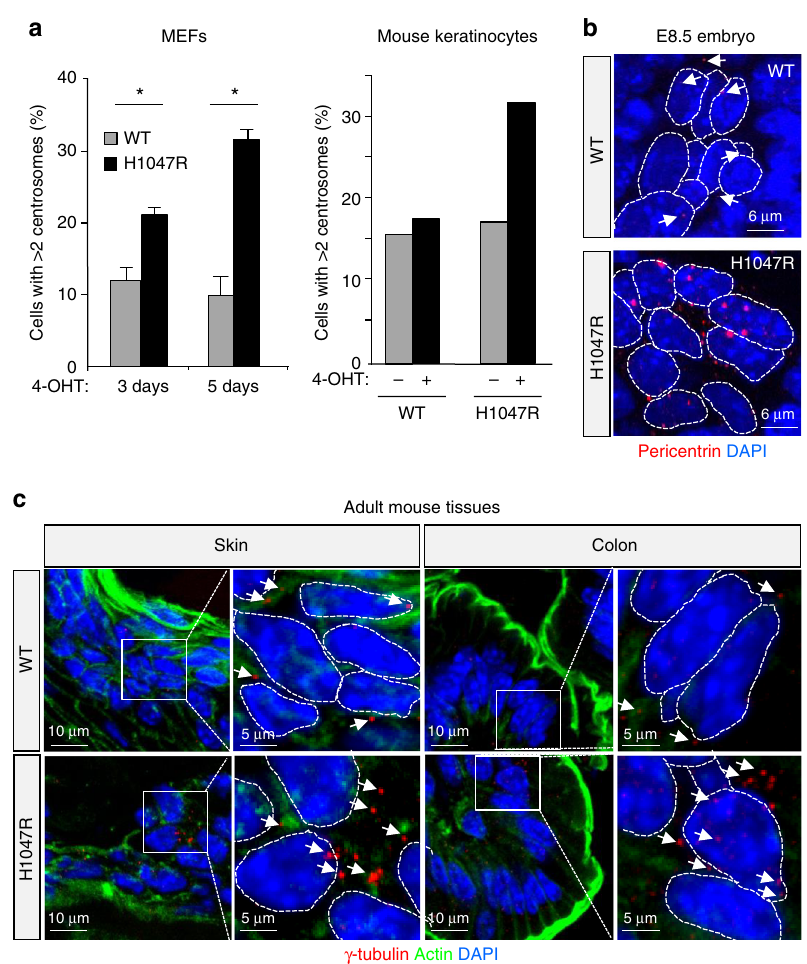
Fig. 2 p110 α H1047R expression leads to centrosome ampli fi cation in cells and tissues. a Frequency of cells with centrosome ampli fi cation ( n > 2) in WT and Pik3ca H1047R primary E13.5 MEFs (72 h after addition of 4-OHT or vehicle; 200 cells were scored per genotype and per time point; values = mean ± SD) and mouse keratinocytes (isolated from 8-week-old Pik3ca WT ; Flpe-ER T2 or Pik3ca H1047R+neo ; Flpe-ER T2 mice, cultured for 7 days of which the last 48 h were in the presence of 4-OHT or vehicle; 400 cells were scored per genotype and per condition). Statistically signi fi cant differences are indicated by *( P < 0.05), as determined by non-parametric Mann – Whitney t test (one-tailed). b Whole-mount of E8.5 embryos stained for pericentrin. Dashed lines contour single-cell nuclei. White arrows point towards individual centrosomes in the WT cells. Mutant embryos show enlarged and ampli fi ed number of centrosomes per cell. c Cryosections of skin and colon of 8-week-old Pik3ca WT ; Flpe-ER T2 and Pik3ca H1047R+neo ; Flpe-ER T2 mice treated for 5 consecutive days with tamoxifen (80 mg kg − 1 by gavage), stained for γ -tubulin (red) and actin (green). White arrows point towards centrosomes. Dashed lines contour single-cell nuclei. White boxes surround areas that are magni fi and led to PI3K pathway activation (Fig. 1c). Enhanced Akt phosphorylation was also observed in primary fi broblasts from human fi bro-adipose overgrowth syndrome patients with mosaic, heterozygous expression of the PIK3CA H1047L mutation 21 (Supplementary Fig. 1c).